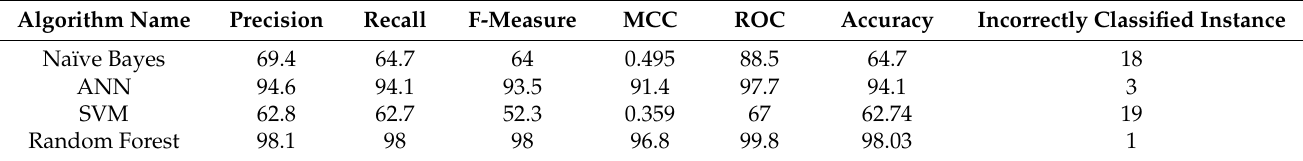
Table 6. Comparison among classification algorithms during the training phase to predict the total recovery cases.